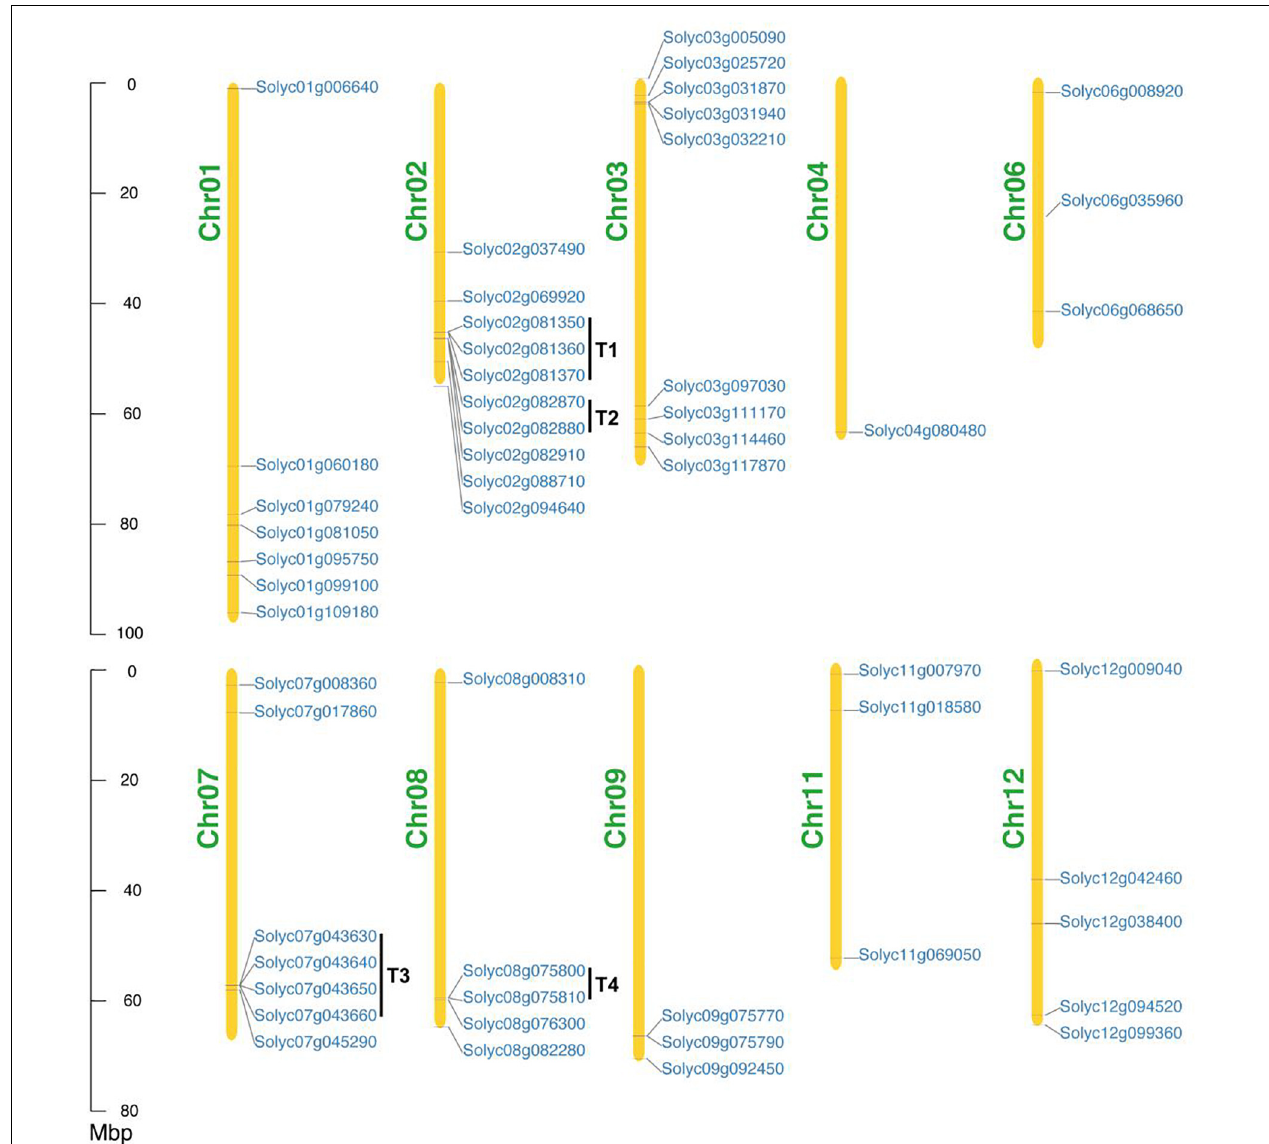
FIGURE 5 | Chromosomal locations of SlAAE genes. In total, 53 SlAAE genes are distributed on 10 of 12 tomato chromosomes. Mbp indicates the scale. T, tandem duplication; Chr, chromosome.